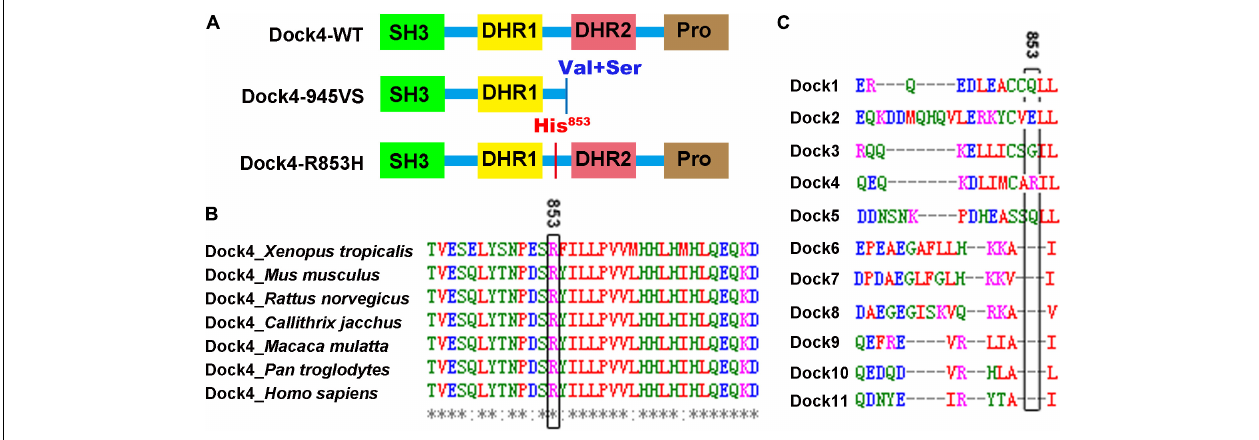
FIGURE 1 | Arg 853 is a unique site of Dock4 among all Dock family members and is highly conserved during evolution. (A) Domain illustrations of Dock4 mutants associated with autism spectrum disorder and dyslexia. (B) The 853 th Arginine residue of Dock4 is highly conserved in different species during evolution. (C) The 853 th Arginine residue of Dock4 is not conserved in other Dock family